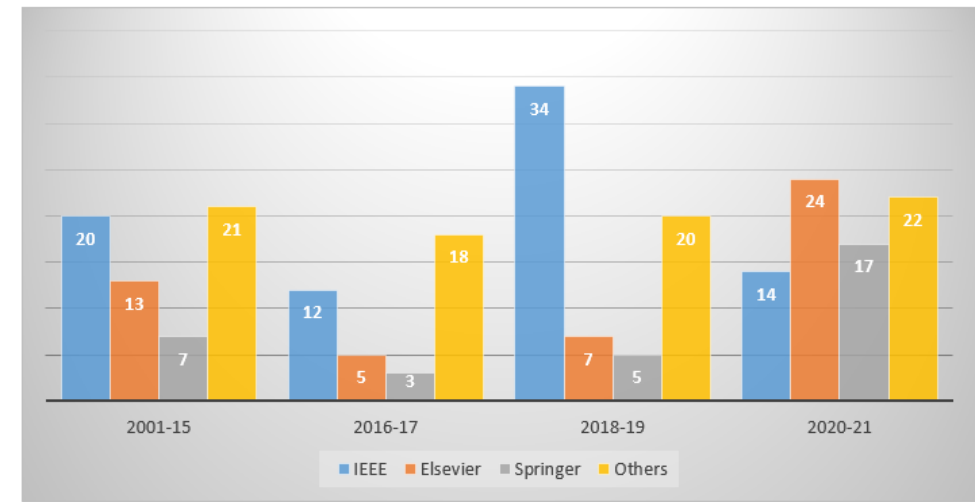
Figure 3. Sports research progress in past five